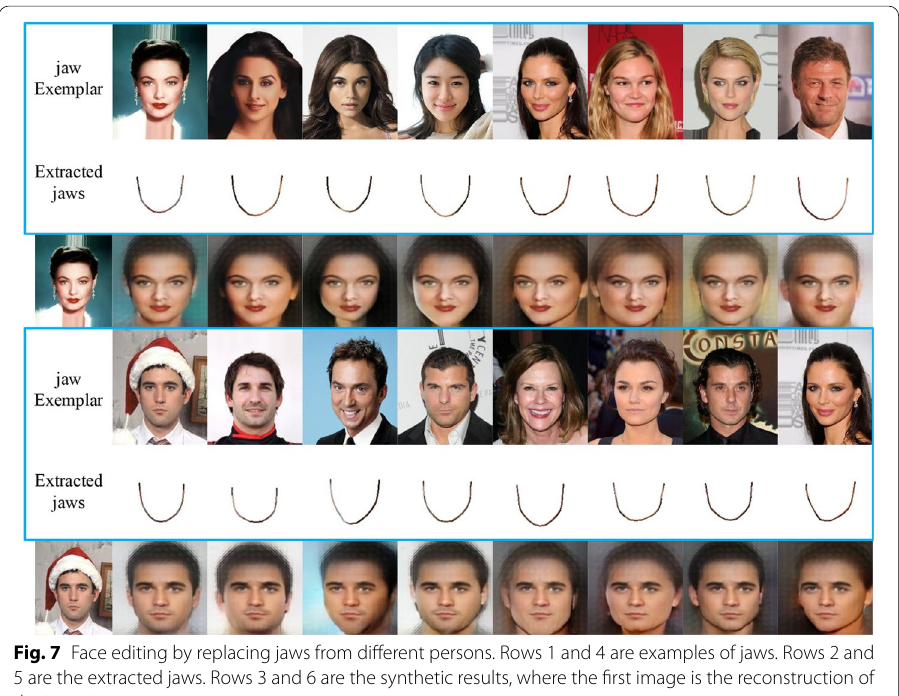
Fig. 7 Face editing by replacing jaws from different persons. Rows 1 and 4 are examples of jaws. Rows 2 and 5 are the extracted jaws. Rows 3 and 6 are the synthetic results, where the first image is the reconstruction of the input image